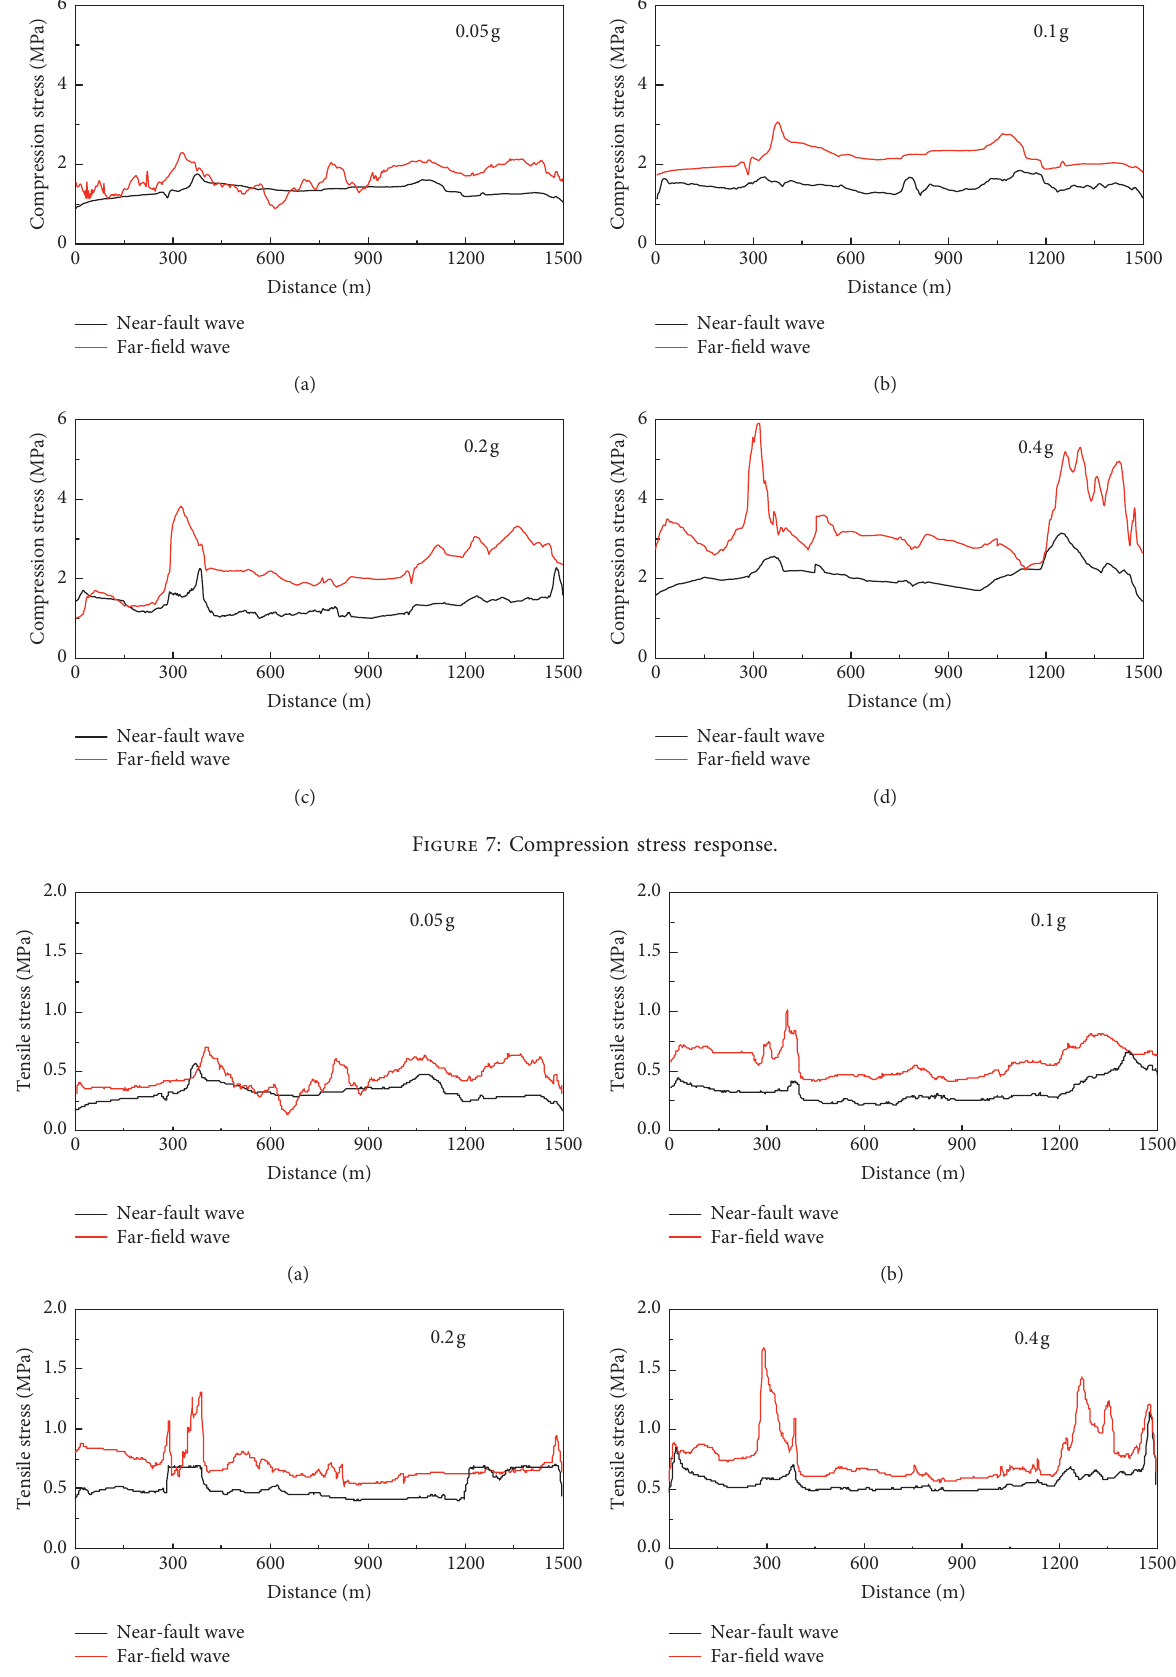
Figure 7: Compression stress response.